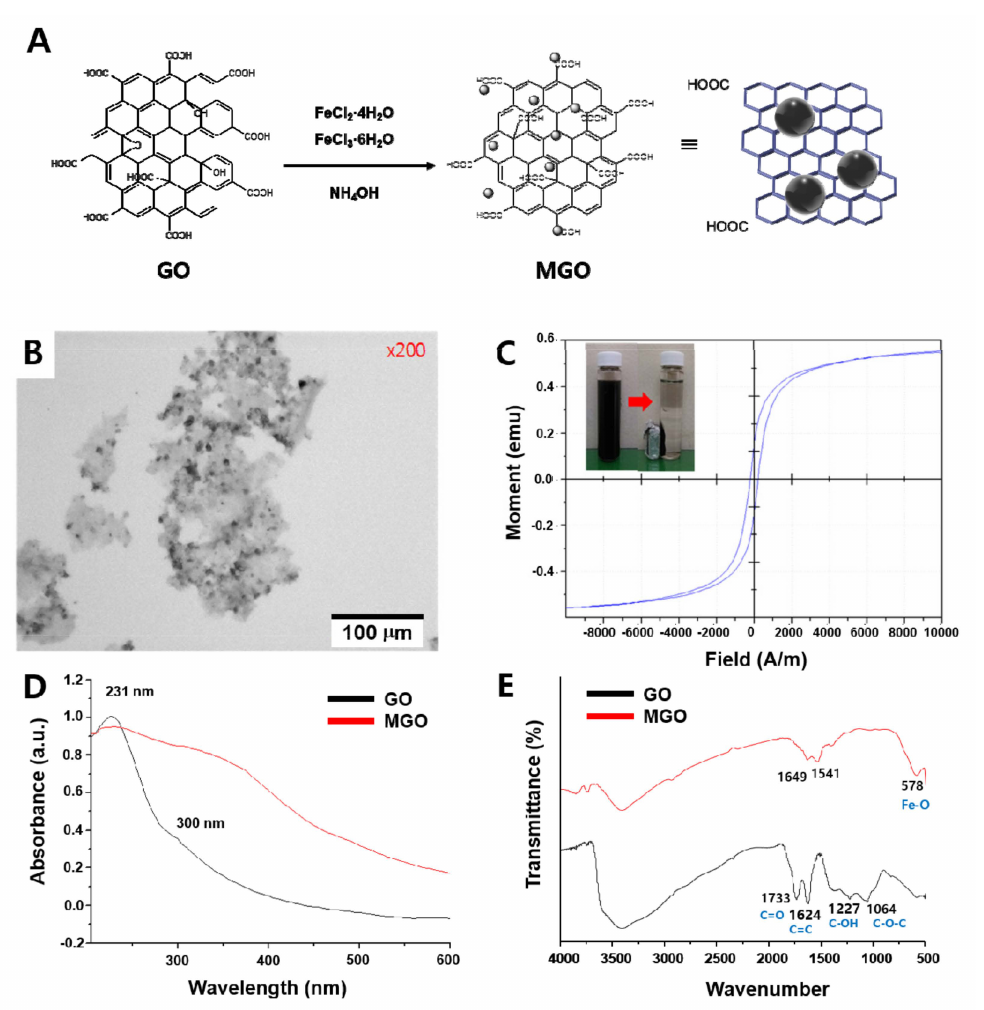
Figure 1. Preparation and characterization of graphene oxide (GO) and magnetic graphene oxide (MGO). ( A ) Schematic of MGO synthesis procedure. ( B ) Optical microscopy image of MGO. ( C ) Magnetic hysteresis loop of MGO. ( D ) UV / Vis absorption spectra of GO and MGO. ( E ) FT-IR spectra of GO and